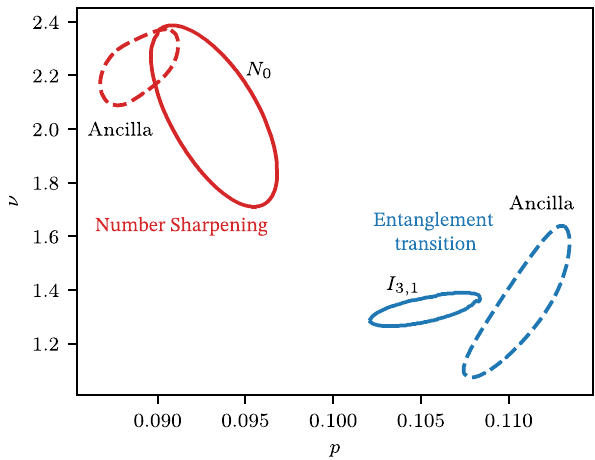
FIG. 5. Two transitions. Plot of the 68% confidence interval of the critical point p and the correlation length exponent ν for both the entanglement and charge transitions. The mutual information I 3 (solid blue circle) and the ancilla probe (dashed blue circle) ; 1 are for the entanglement transition, while the fraction of trajec- tories N 0 (solid red circle) and the ancilla probe (dashed red circle) are for the charge-sharpening phase transition. The two transitions appear to be different with statistical significance, although we cannot exclude systematic finite size effects that would change this conclusion in the thermodynamic